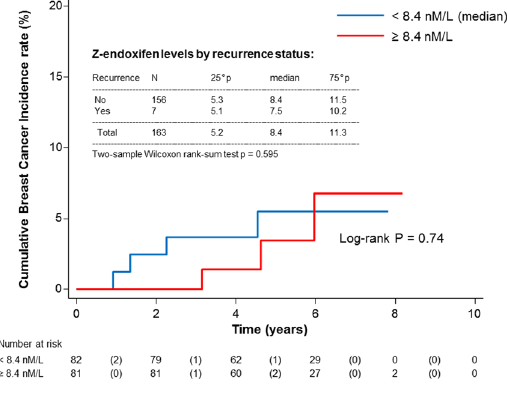
Fig. 1 Cumulative breast cancer recurrence curves in the tamoxifen arm according to Z-endoxifen, nmol/L and by recurrence status (yes/no). Red line represents subjects with endoxifen level above the median value, the blue line below the median value (log-rank p = 0.74).